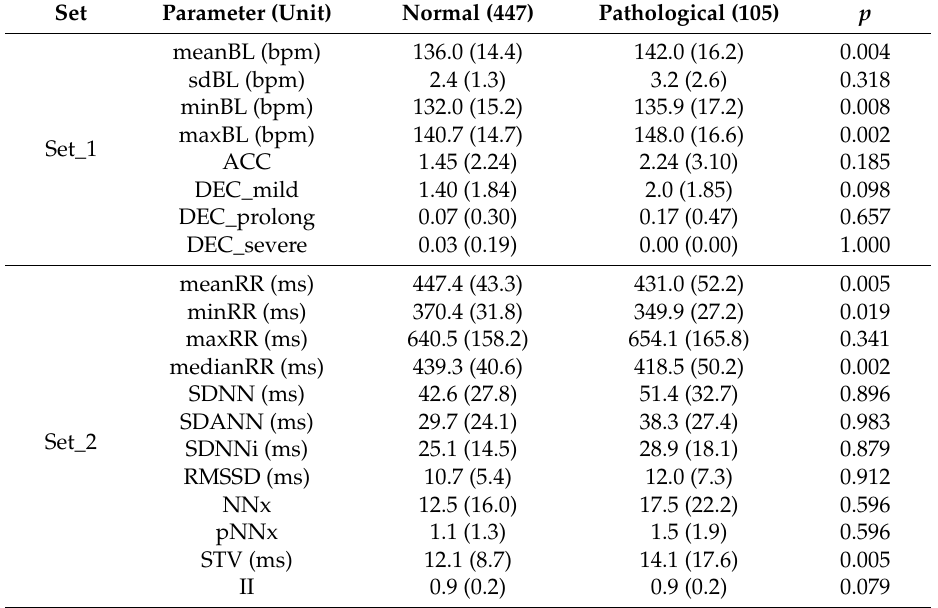
Table 3. Features extracted from the FHR signals for the normal and pathological groups (Set_1: Morphological; Set_2: Time domain). Key: Values are given as the mean (standard deviation). p ‐values were calculated using the Wilcoxon‐Mann‐Whitney nonparametric test with a significance level of 0.05.